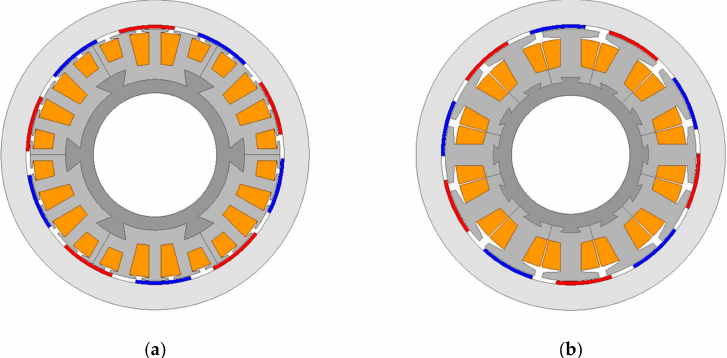
Figure 7. Variation of the phase di ff erence between the electromotive forces (EMFs) of the two groups of windings in the proposed machine with h y1 ( h y2 = 9 mm constantly).